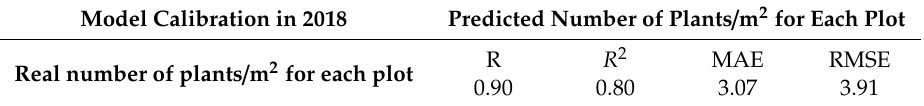
Table 4. Statistical parameters for comparison of the real and predicted number of plants / m 2 for each plot in model calibration. R—correlation coe ffi cient, R 2 —correlation of determination, MAE—mean absolute error, and RMSE—root mean squared